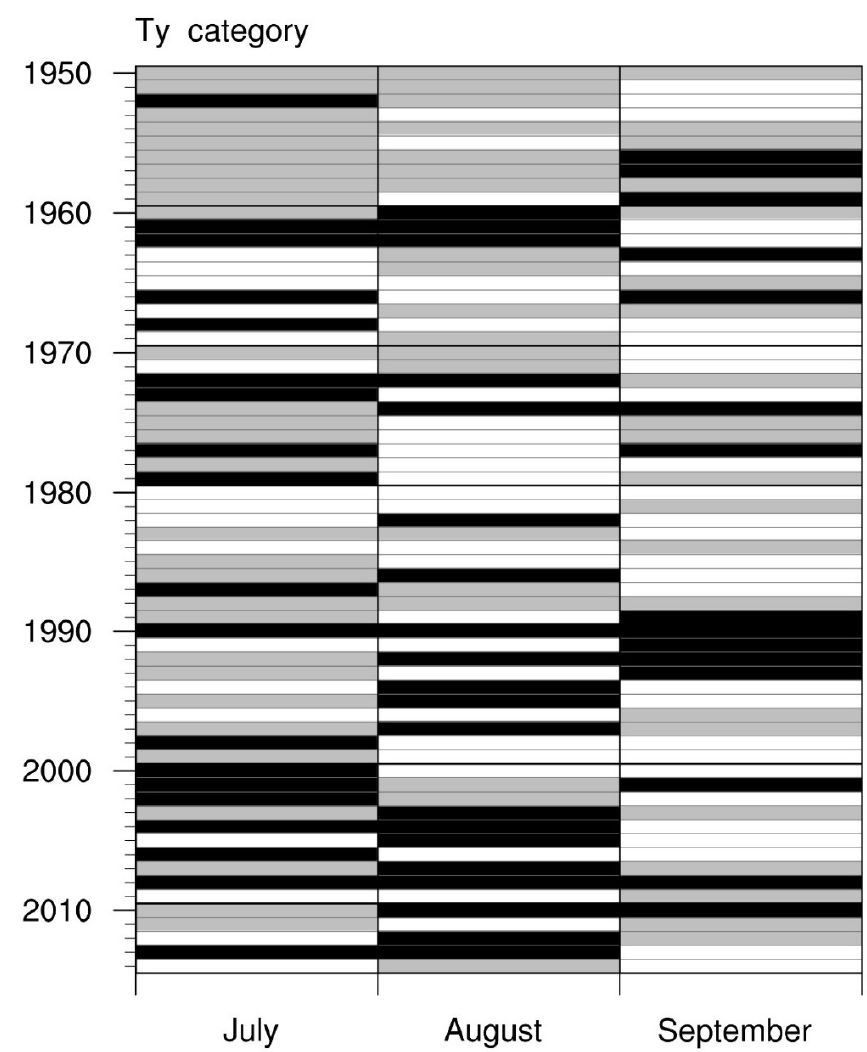
Figure 1. Different categories sorted by the typhoon invasion days for the typhoon season in Taiwan over the analyzed years. Black for the Ty+ category, gray for the Ty– category, and white for the normal cases.